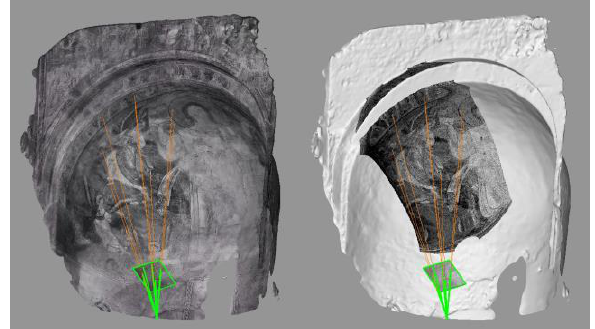
Figure 6. On the left, point cloud density analysis displayed on the point cloud. On the right, image overlap scheme.